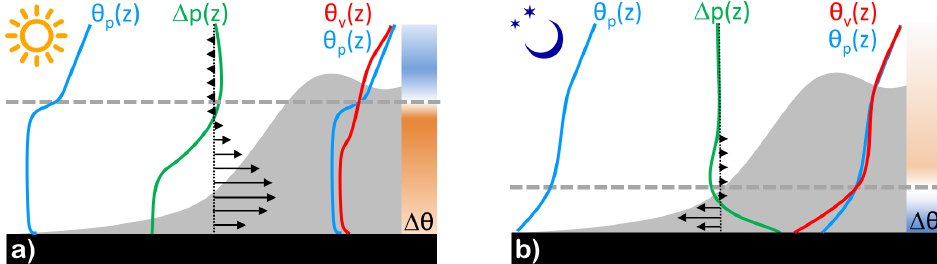
Figure 2. Thermally driven winds in a valley with horizontal floor (adapted from [18,115,117]). ( a ) During the day, the atmosphere in the valley (red profile, θ v ) is warmer than that over the plain (blue profiles, θ p ). The largest imbalances ( ∆ θ = θ v − θ p ) are often found near mountain top level. Horizontal pressure differences ( ∆ p = p v − p p ) result quasi-hydrostatically from the vertically integrated temperature imbalances, and are typically largest at the valley floor. The wind responds to the pressure gradient and is decelerated by friction near the ground. Deeper convective mixing in the valley causes an elevated cool anomaly, which may drive an upper-level return flow. ( b ) The opposite situation occurs at